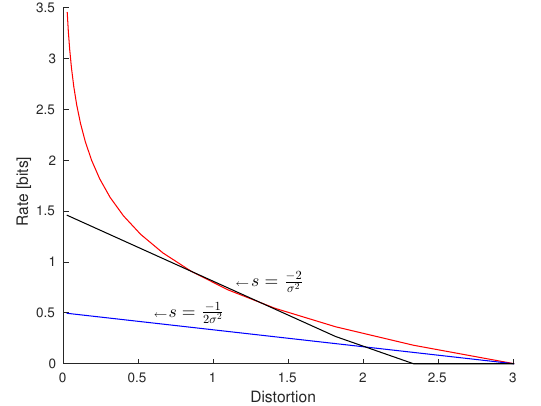
Fig. 3. Relationship between parameter s and R ( D ) curve.